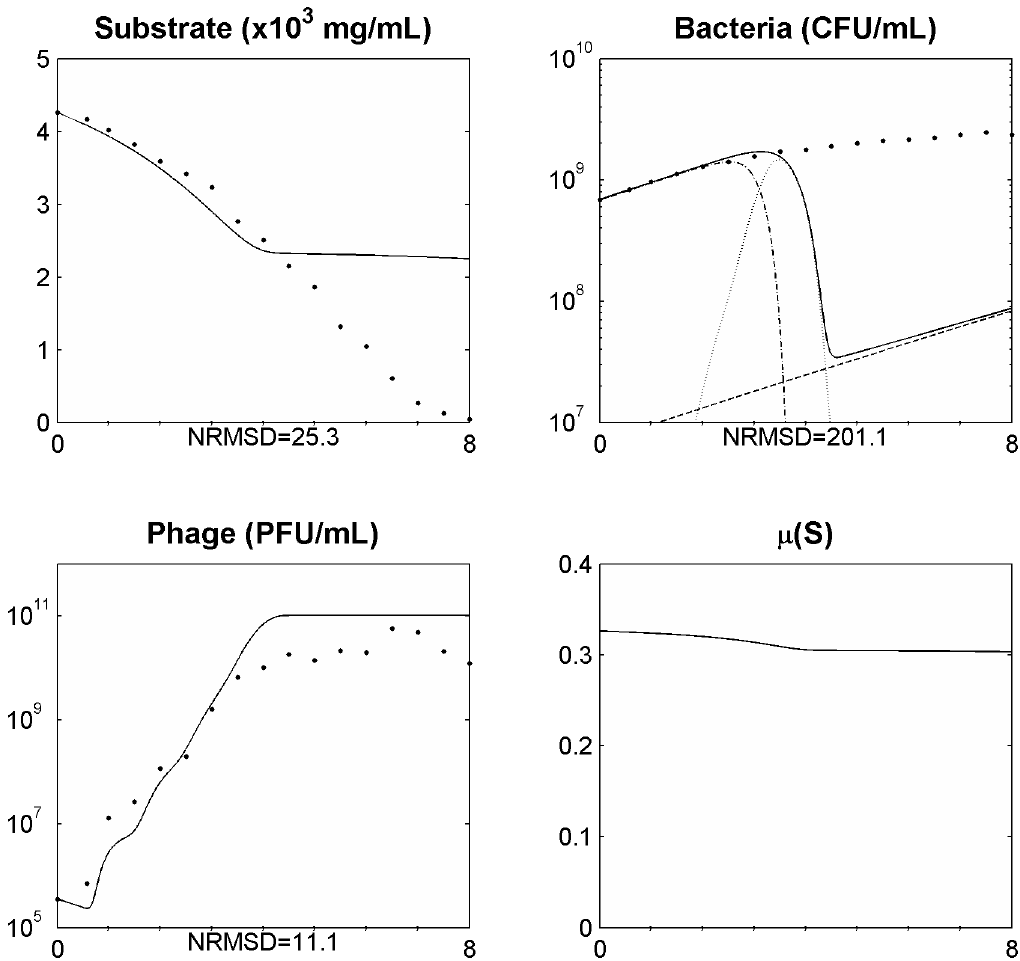
Figure 3. Simulating the phage and bacteria population dynamics using a distribution of values of the latent period (equations 5 and 13) in a 5 L bioreactor for a MOI=5.1E10 2 4 . Legend: N experimental data; ___ model simulation; - . - model simulation of susceptible uninfected bacteria ( X s ); … model simulation of infected bacteria ( X i ); _ _ model simulation of resistant bacteria ( X r ). The x axis represents time in hours.